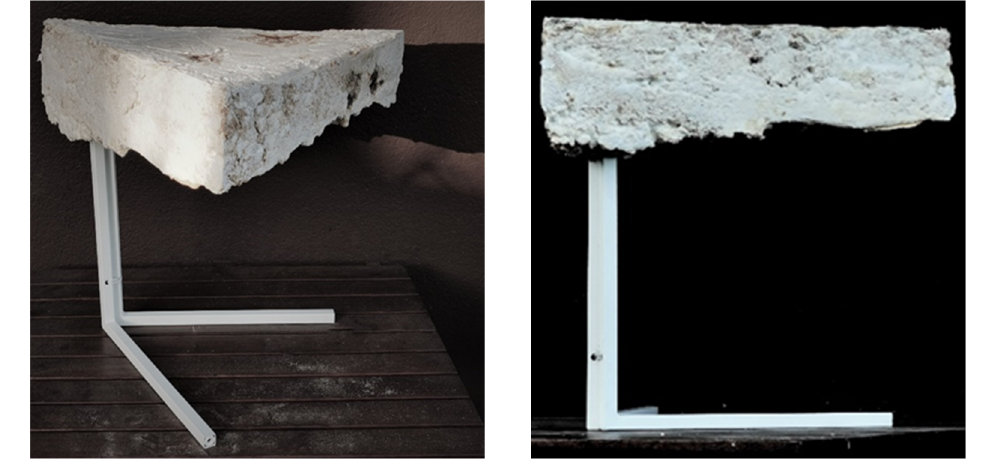
Figure 14. Coffee table with mycelium-based tabletop (design and photo: A. Bonenberg).